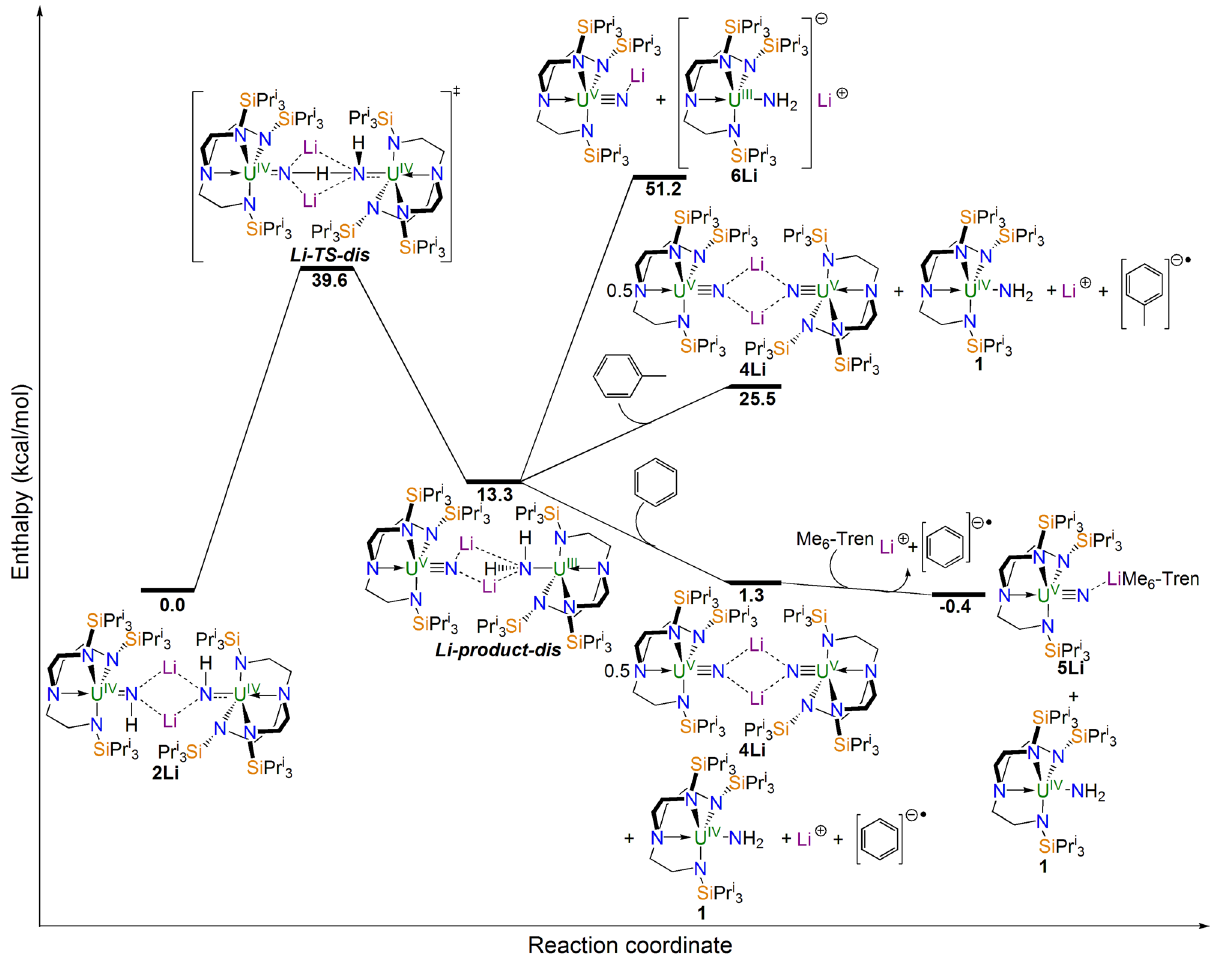
Fig. 9 Computed reaction pro fi le for the hypothetical disproportionation of 2Li to 4Li/1/Li + (C 6 H 6 ) − (cid:129) . Complex 2Li containing two uranium(IV) ions reacts via transition state Li-TS-dis to give the disproportionation intermediate Li-product-dis where uranium(V) and (III) ions are formed, but this is an endothermic reaction. Spontaneous cleavage of Li-product-dis to two monomer units is clearly disfavoured, as is reaction with toluene to give 4Li , 1 , and the lithium toluene radical anion salt. If Li-product-dis formed it would, however, react with benzene to give 4Li , 1 , and the lithium toluene radical anion salt. Complex 4Li would then converted to 5Li using the capping agent Me 6